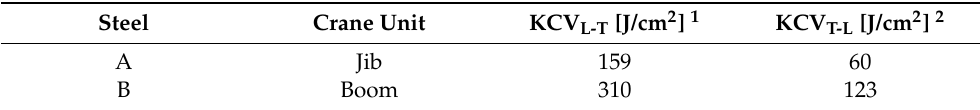
Table 3. Impact toughness experimentally observed for studied steels.